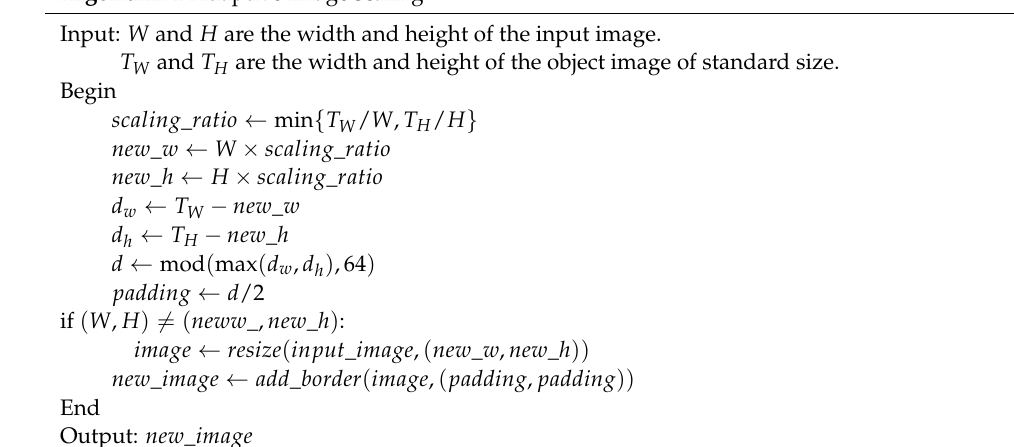
Algorithm 1 Adaptive image scaling.